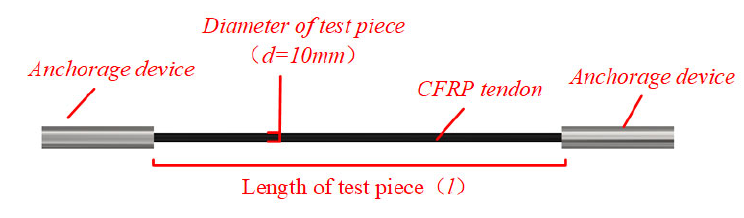
Figure 1. The test